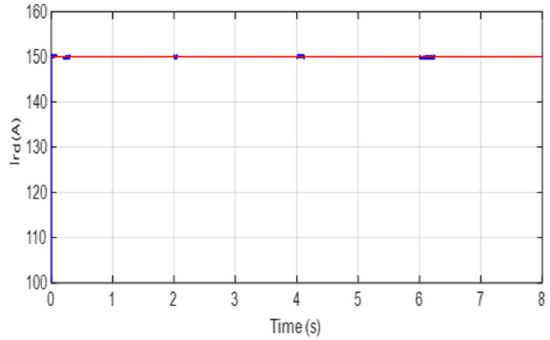
Fig. 17 Current tracking performance for